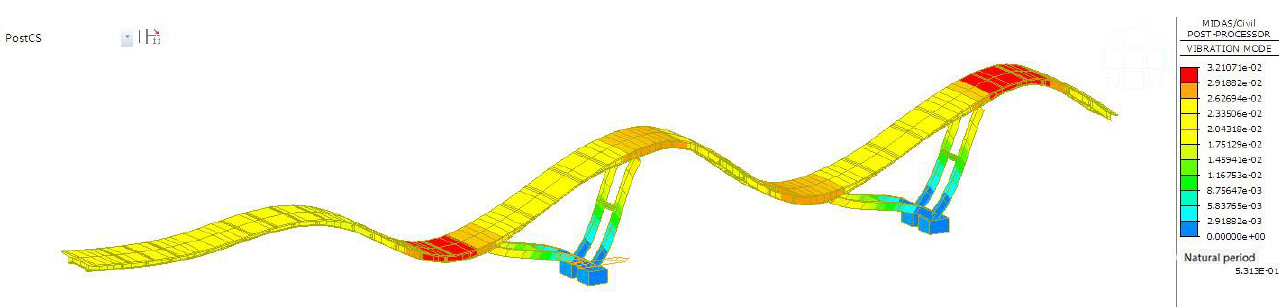
Figure 15. One-half design stiffness elastic connection first-order vertical vibration diagram /m.